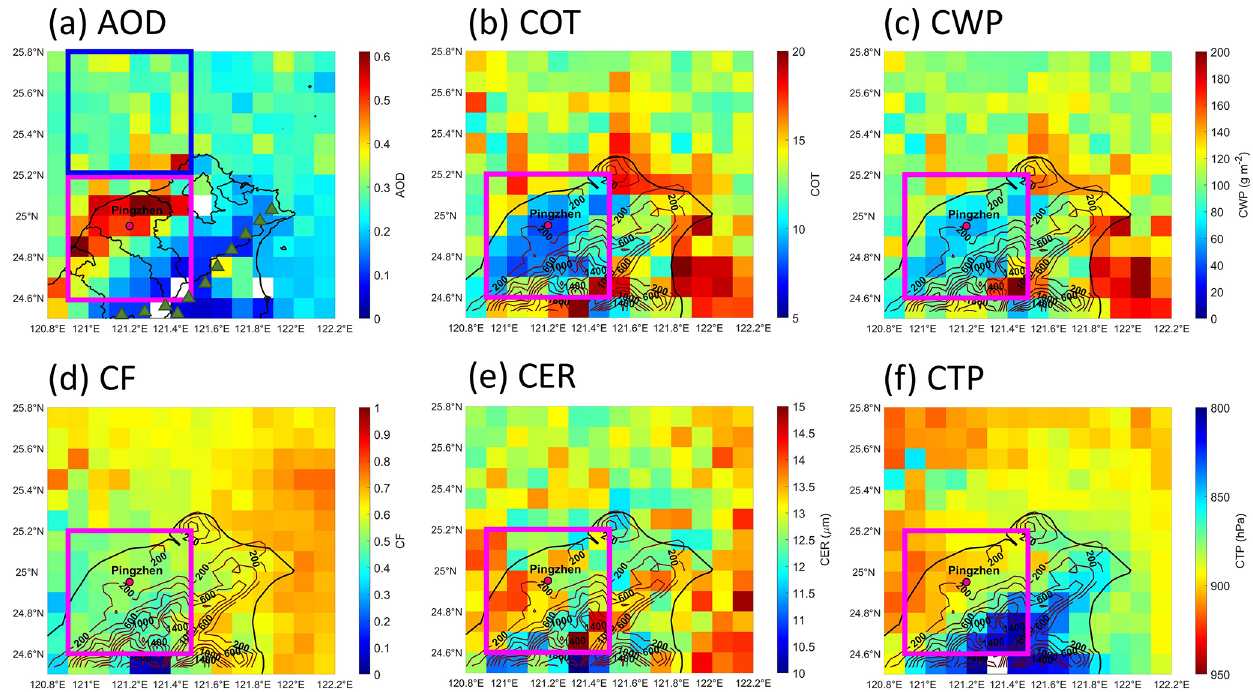
Figure 3. Average (a) aerosol optical depth (AOD), (b) cloud optical thickness (COT), (c) cloud water path (CWP), (d) cloud fraction (CF), (e) cloud effective radius (CER), and (f) cloud-top pressure (CTP) in warm clouds from 15 October to 30 November 2005–2017. The magenta box represents the main study area (24.6–25.2 ◦ N, 120.9–121.5 ◦ E), and the blue box in (a) is the remote area (25.2–25.8 ◦ N, 120.9–121.5 ◦ E). The green triangles in (a) mark the location of the Xueshan mountain range. The topography of northern Taiwan is depicted with brown-colored contour lines (in meter) in (b–f) . Table 2. ACI values from the literature in comparison to this